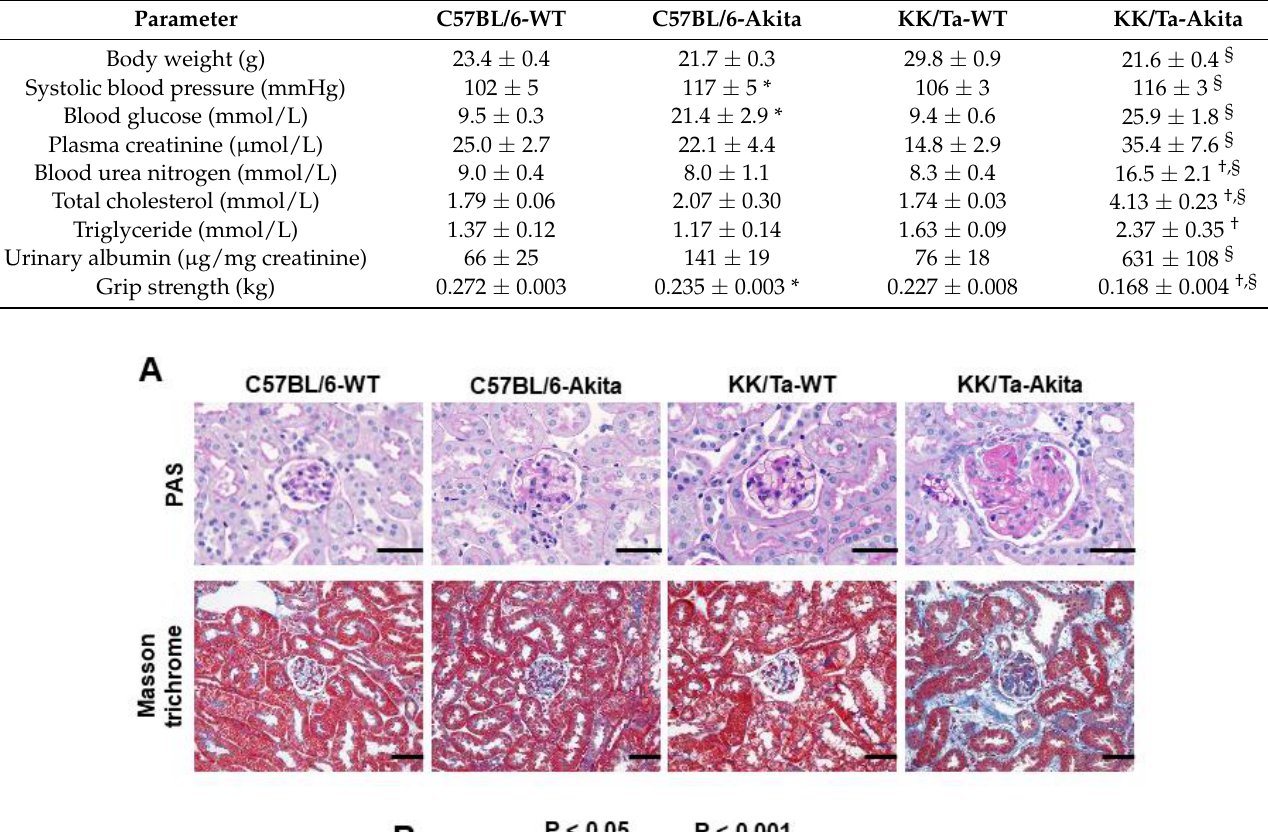
Table 1. Physiological and biochemical parameters in 15-week-old C57BL/6-Akita and KK/Ta-Akita mice. Values are means ± SEM. n = 6 per each group except grip strength. n = 4 per each group for grip strength. * p < 0.05 vs. C57BL/6-WT. † p < 0.05 vs. C57BL/6-Akita. § p < 0.05 vs. KK/Ta-WT.